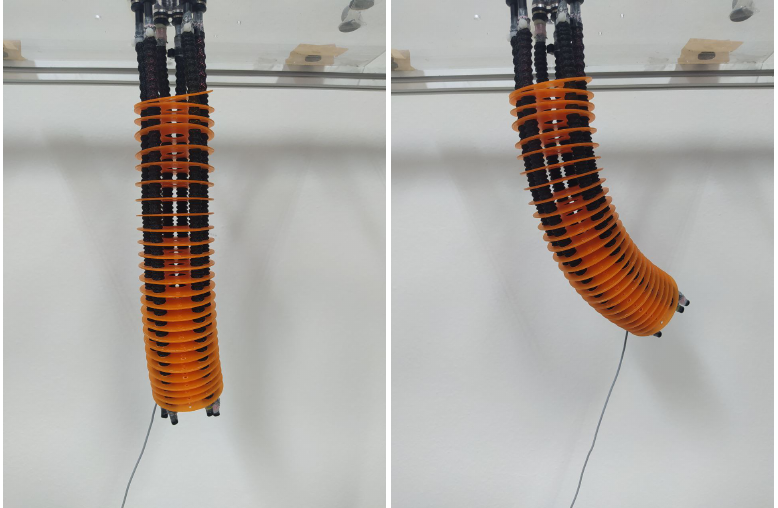
Figure 2. Left : elongated I-Support module, with three equally actuated chambers. Right : bended module with only one chamber